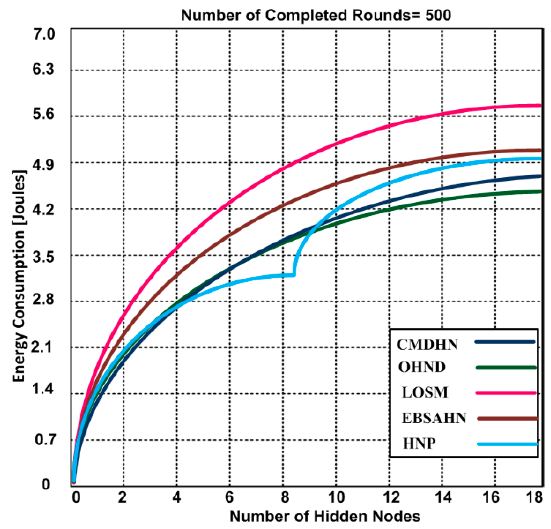
Figure 8. Energy consumption vs. number of hidden nodes.